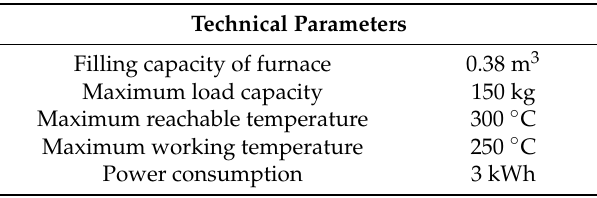
Figure 2. The photograph of the thermal chamber used for the treatment including the arrangement of the samples inside ( a ) and the photograph of the conditioning chamber used for the conditioning after heat treatment including the arrangement of the samples inside ( b ). Table 1. Parameters of the Thermal Chamber.